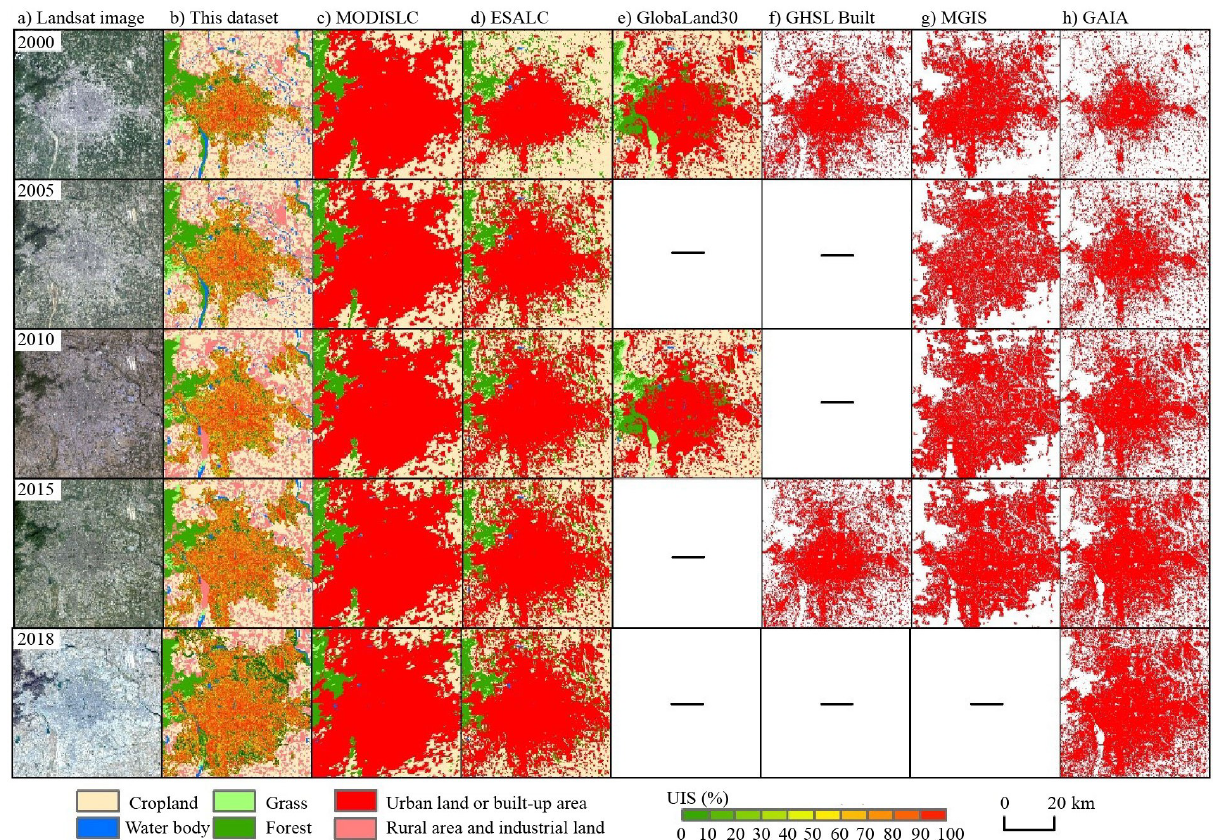
Figure 12. A comparison of urban land cover between this product and other datasets in Beijing. The Landsat images were provided by the Geospatial Data Cloud site, Computer Network Information Center, Chinese Academy of Sciences (http://www.gscloud.cn, last access: 20 August 2000 for 2000, 8 September 2005 for 2005, 8 June 2010 for 2010, 23 September 2015 for 2015, and 8 April 2018 for 2018).